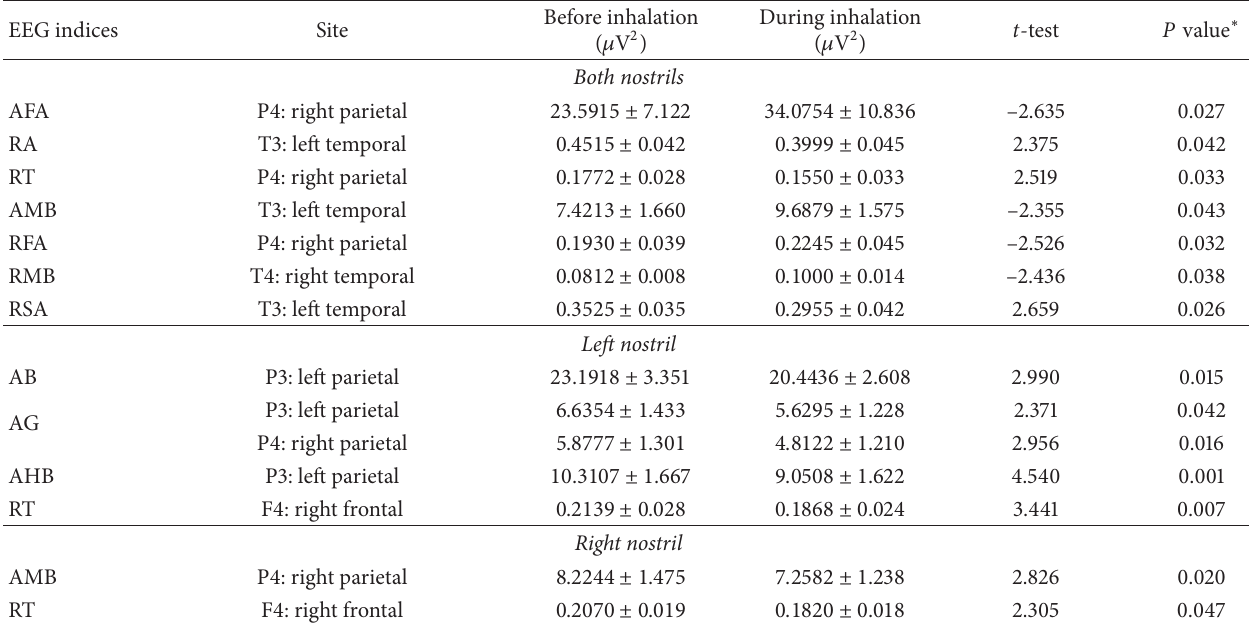
Table 7: Effect of inhalation of essential oil of A. koreana twigs on EEG activity in women (both, left, and right nostrils). EEG